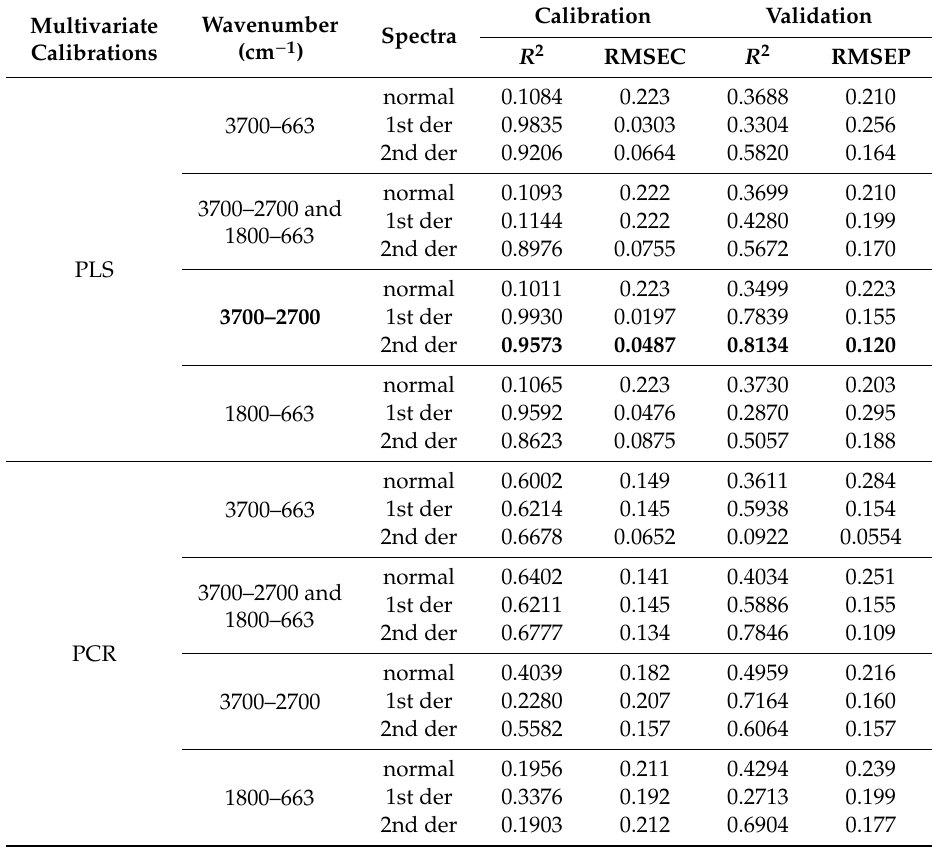
Table 3. The statistical parameters of multivariate calibrations of principle component regression (PCR) and partial least square (PLS) for the quantitative analysis of γ -mangostin